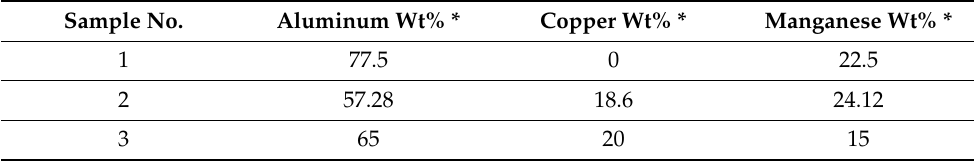
Table 1. Powder Compositions concerning wt% used in the present study. Sample No.